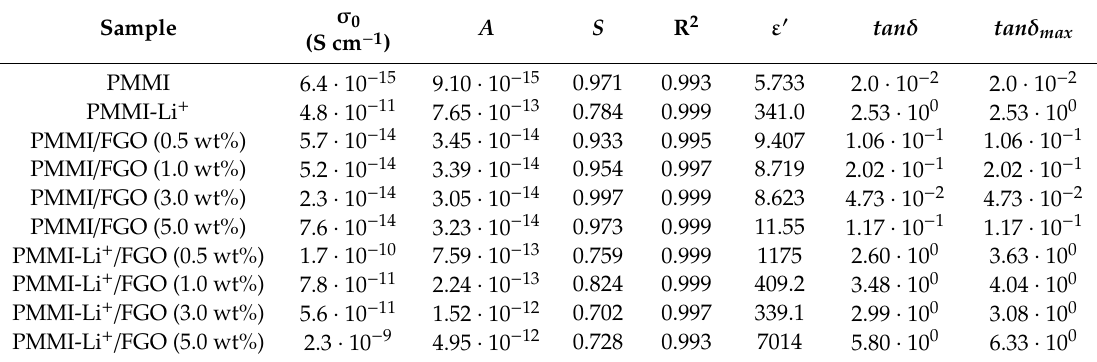
Table 2. Jonscher’s parameters, ε (cid:48) , tan δ and tan δ max of nanocomposites. σ Sample